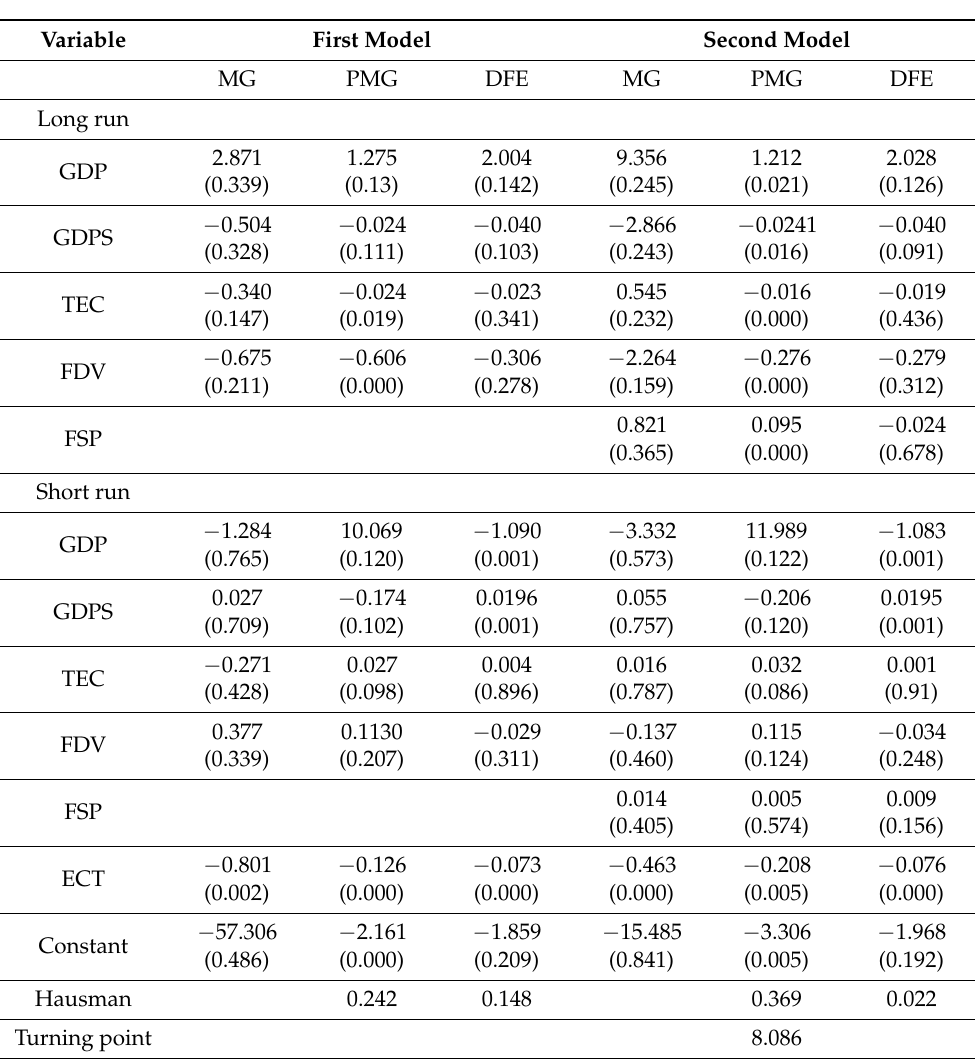
Table 6. Panel ARDL